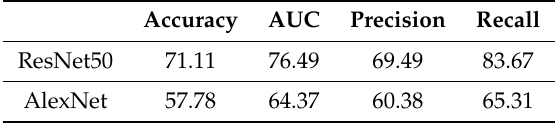
Table 8. Results of the AlexNet and the ResNet50 trained from scratch on our